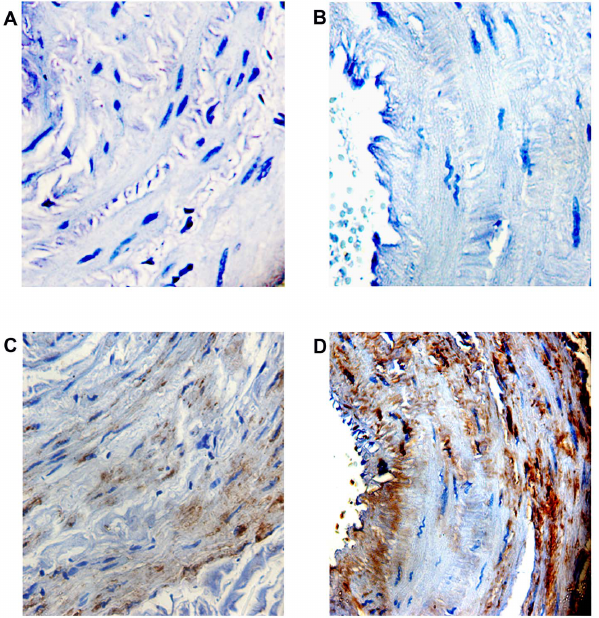
Figure 3. Photomicrograph demonstrating immunohistochem- ical staining with FoxC2 antibody in venous tissue sections from patients with varicose veins and controls. (A) Negative staining control in normal saphenous veins and (B) varicose vein tissues. (C) FoxC2 expression is localized to tunica media in normal venous tissue section. (D) FoxC2 is expressed all over intima and media of varicose vein tissues with high staining intensity, original magnifi- cation x 400.